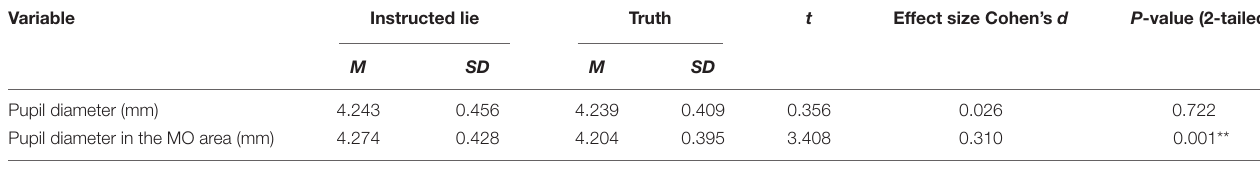
TABLE 1 | The analysis of pupil size in Study 1. Variable Instructed lie